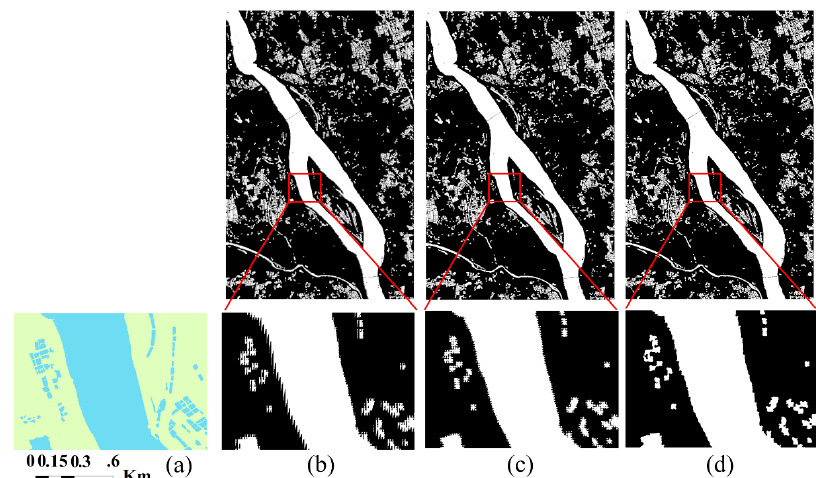
Figure 13. Subpixel water mapping results for Region A: ( a ) reference image; ( b ) SPM L ; ( c ) SPSAM; and ( d ) MSWM.